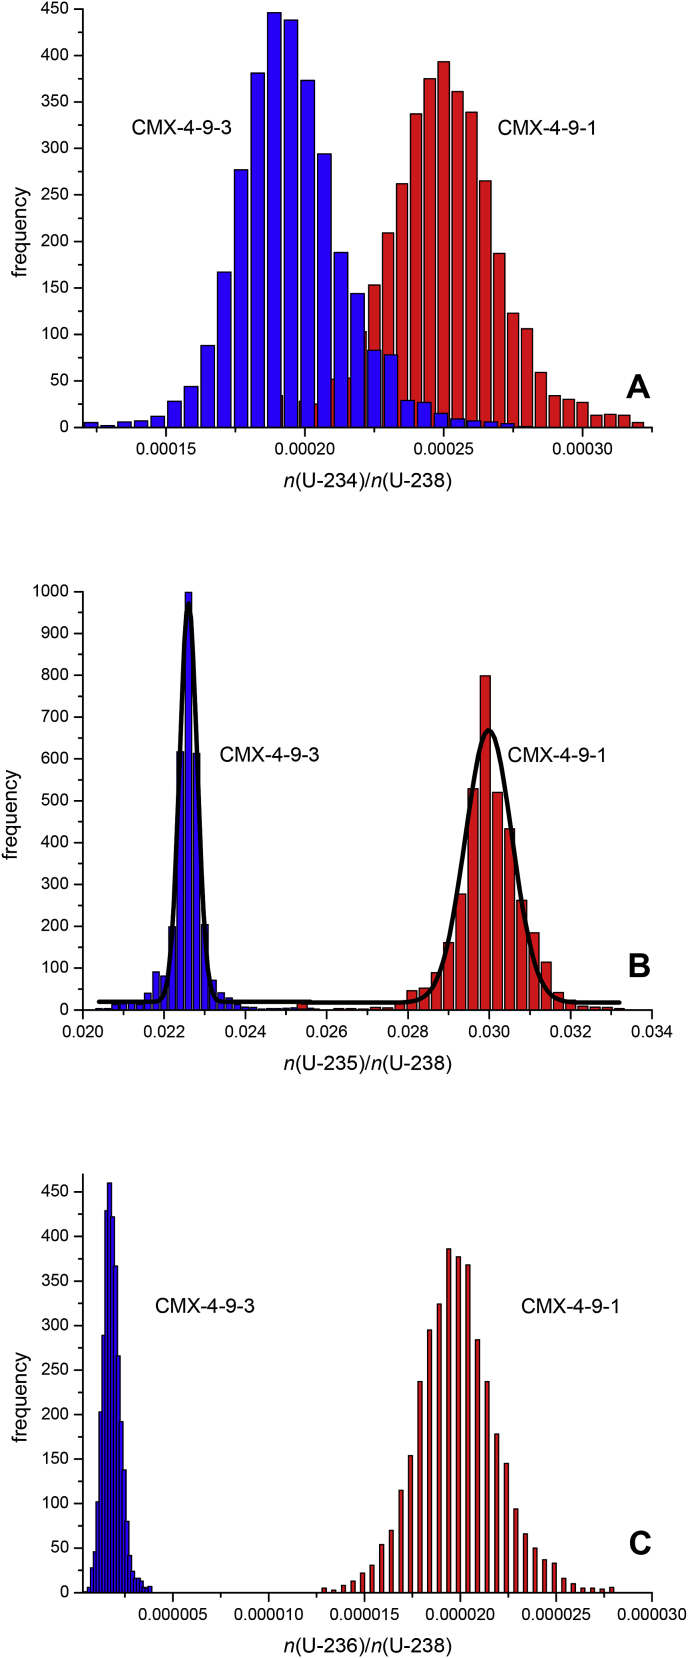
Frequency distribution of major and minor U isotope ratios in samples CMX-4-9-1 and CMX-4-9-3 highlighting the different U isotopic composition of both UO2 pellets. The bold solid lines in panel B highlight the normal fit of the respective frequency distributions of the n(235U)/n(238U) amount ratios. The larger half width of the normal fit of sample CMX-4-9-1 indicates larger isotopic inhomogeneity compared to UO2 pellet CMX-4-9-3. See text for details.